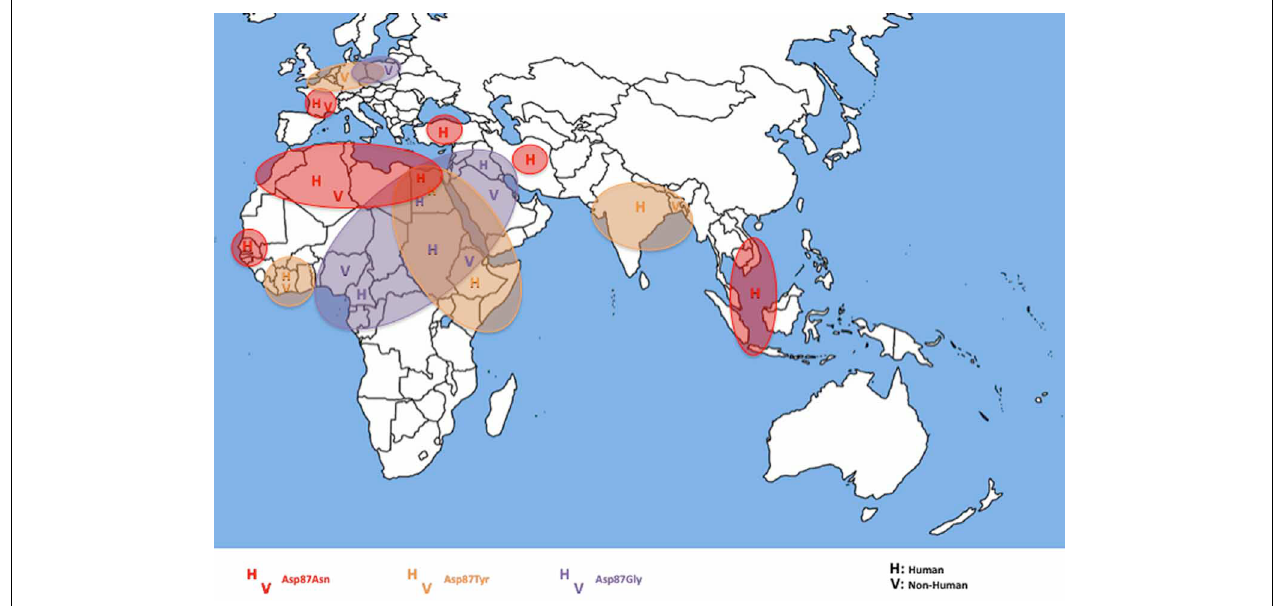
FIGURE 2 | Geographical distribution in the eastern hemisphere of the different substitutions at codon 87 of GyrA to asparagine (Asn), tyrosine (Tyr), or glycine (Gly) in S. enterica serotype Kentucky resistant to ciprofloxacin of the present collection. H, Human isolates; V, nonhuman isolates.